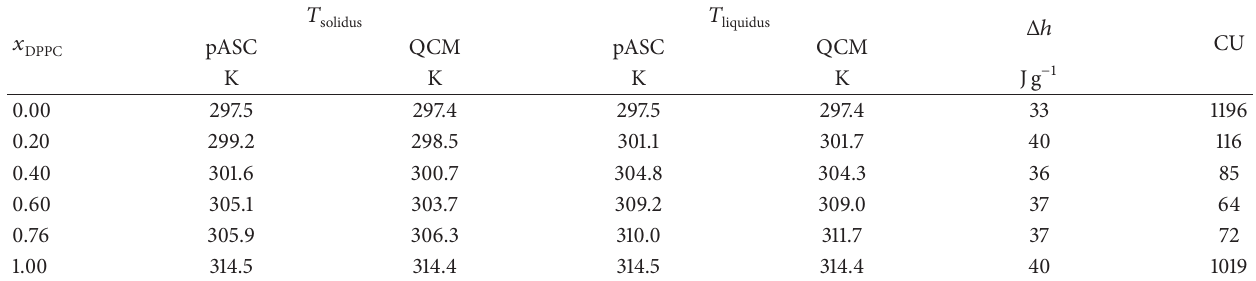
Table 2: Onset and completion temperatures, total heats, and cooperativity unit values for DMPC + DPPC mixtures obtained from pASC measurements, as well as onset and completion temperatures obtained from QCM-D